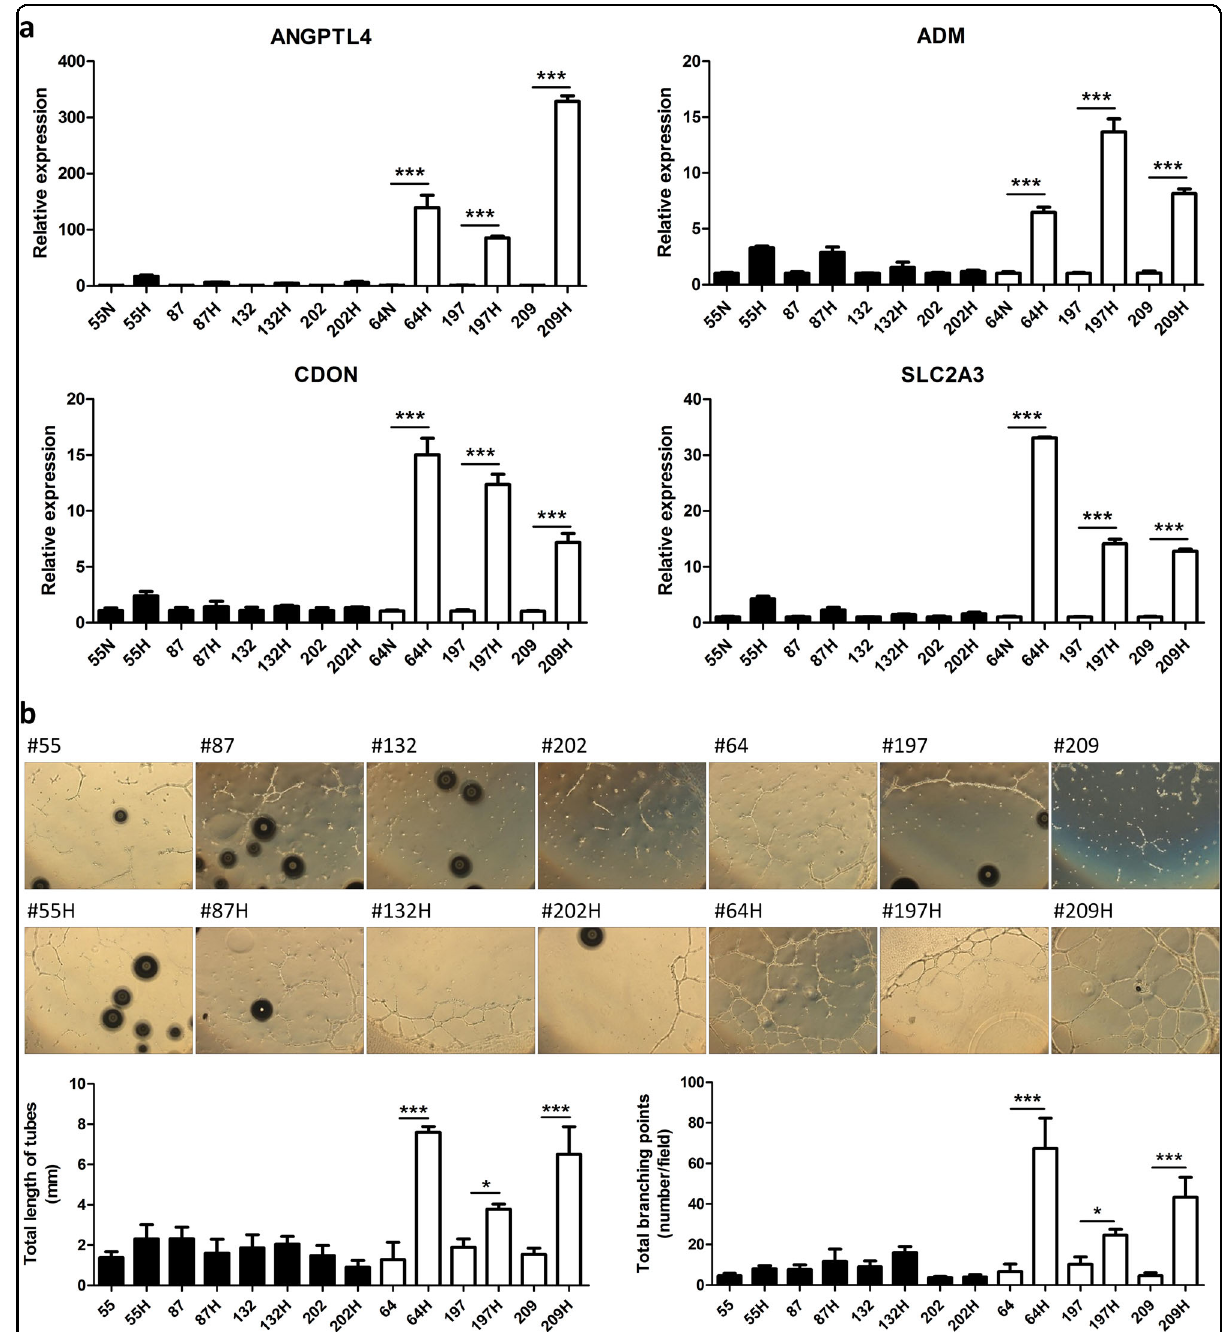
Fig. 7 Validation of selected genes expression by qPCR in low- and high-angiogenesis capacity hUCB-MSCs. a Validation of gene expression of genes selected form NGS (ANGPTL4, ADM, CDON, and SLC2A3) was analyzed by qPCR and show signi fi cant different expression pattern between low-angiogenesis capacity hUCB-MSCs and high-angiogenesis capacity hUCB-MSCs. b Capillary-like tube formation assay of HUVECs co-cultured with hUCB-MSCs #55, #64, #87, #132, #197, #202, #209 was performed and revealed two type of groups, low-angiogenesis capacity (#55, #87, #132, #202) and high-angiogenesis capacity (#64, #197, #209). The angiogenesis capacity of hUCB-MSCs was determined by quanti fi cation of tube formation length and branch junction. Scale bars = 100 μ m. * P < 0.05, *** P < 0.001. Results are shown as the mean ±